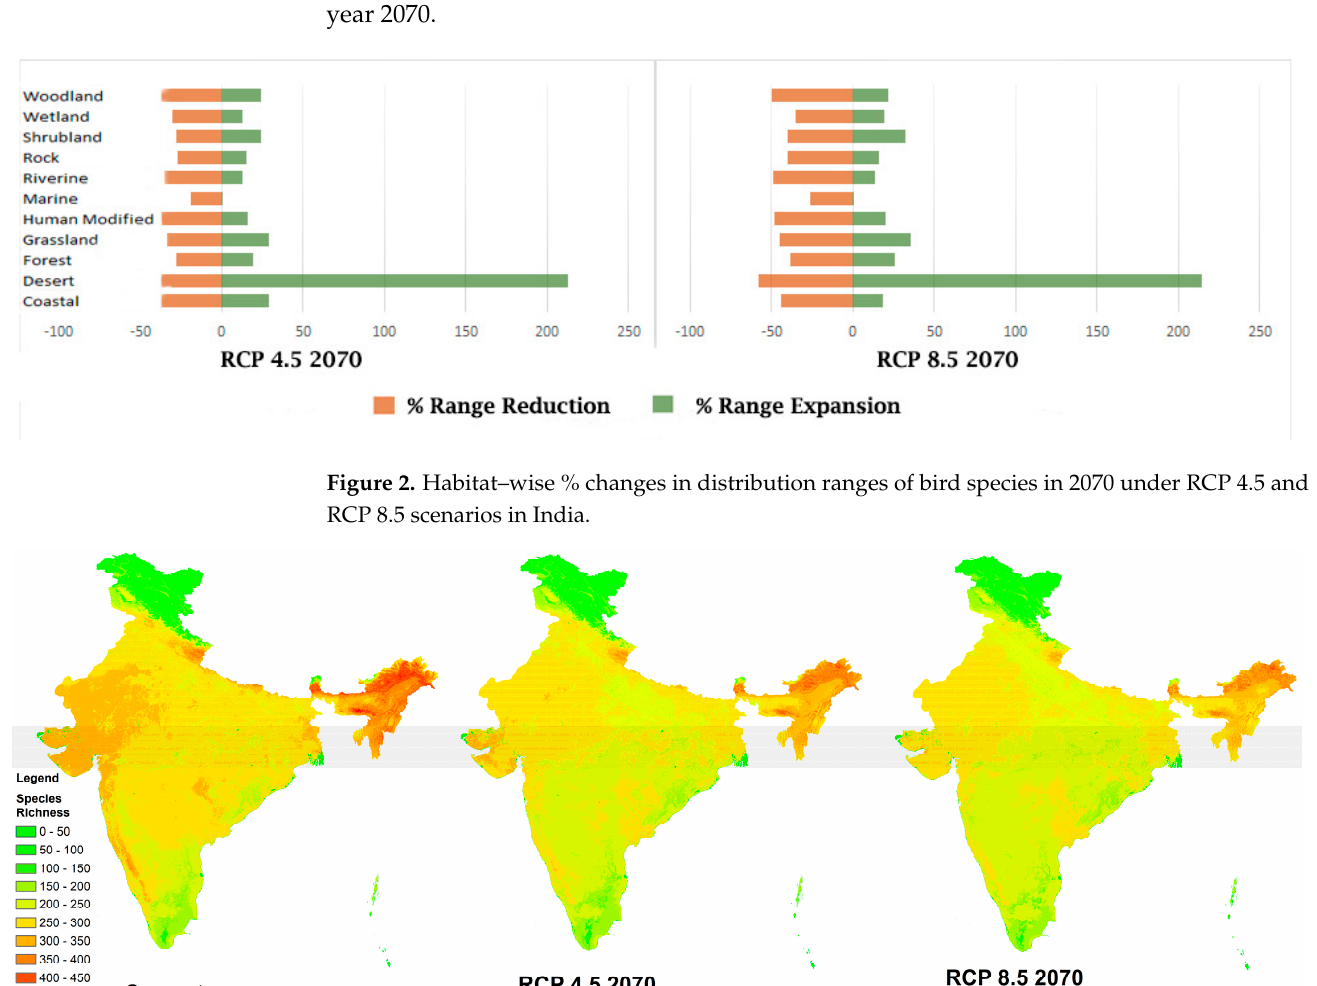
Figure 3. High-resolution maps showcasing bird species richness for the current, RCP 4.5 2070, and RCP 8.5 2070 scenarios in India.